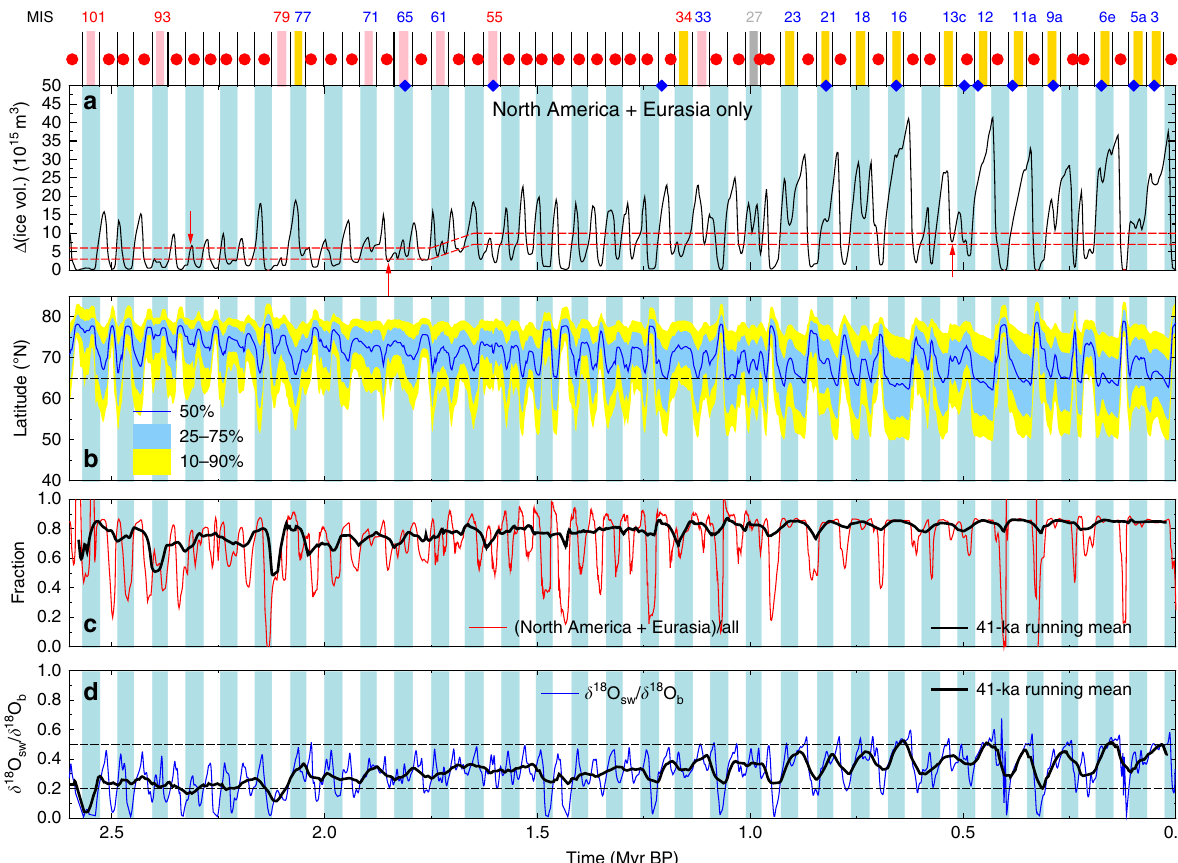
Fig. 2 De fi ning interglacials by land ice volume. For easy identi fi cation of different obliquity cycles, every second cycle (minima-to-minima) is colour coded in light blue bars. a Ice-volume change in North America and Eurasia used to de fi ne interglacials. Two thresholds (broken lines) need to get crossed by the ice volume change to identify an individual interglacial. Vertical arrows mark where and how the thresholds have been constrained by our ice- volume results. Obliquity minima are marked by vertical lines above ( a ). The onset of a new interglacial is marked (red circles), obliquity cycles without new interglacials are colour coded with vertical bars (gold: already found in T17; pink: new in this study: dark grey: found in T17, but not con fi rmed in this study). Marine isotope stages (MIS) in obliquity cycles without a new interglacial are labelled for skipped terminations (blue), or continued interglacials (red). Blue diamonds show obliquity cycles with skipped terminations (and therefore no interglacials) during the last 2 Myr after a different study 20 . b Ice volume in North America and Eurasia as function of latitude. Dark blue line shows the position of the 50% line, implying that half of the ice volume is situated either north or south of it. Yellow (light blue) area shows the latitudinal position of 10 – 90% (25 – 75%) of the ice volume. c The fraction of change in North America and Eurasia ice volume in relation to ice-volume changes globally. d Fraction of δ 18 O caused by ice-volume (sea level) changes. Seawater δ 18 O δ 18 O 29 . To guide the eye, two broken lines at 0.2 and 0.5 are SW is the ice-volume contribution to benthic b as deconvolved earlier